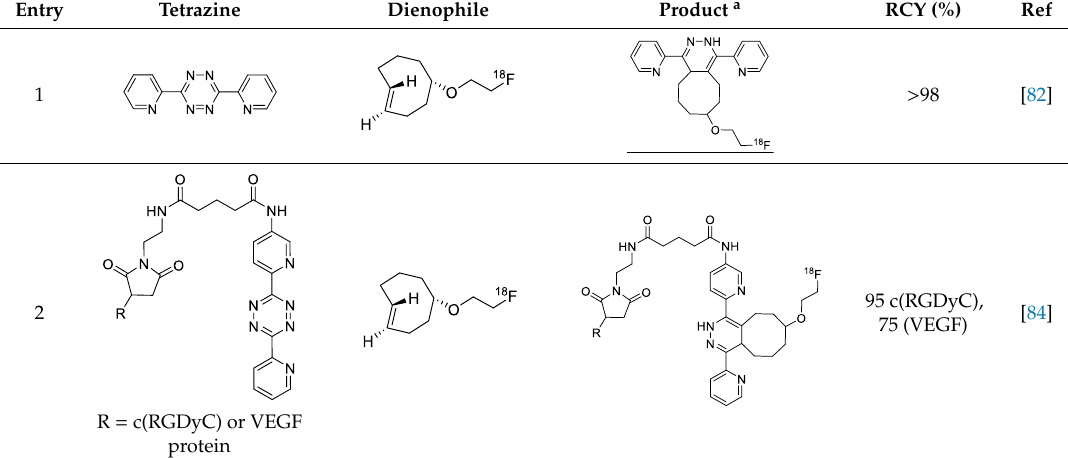
Table 2. IEDDA-mediated in vitro radiolabeling.